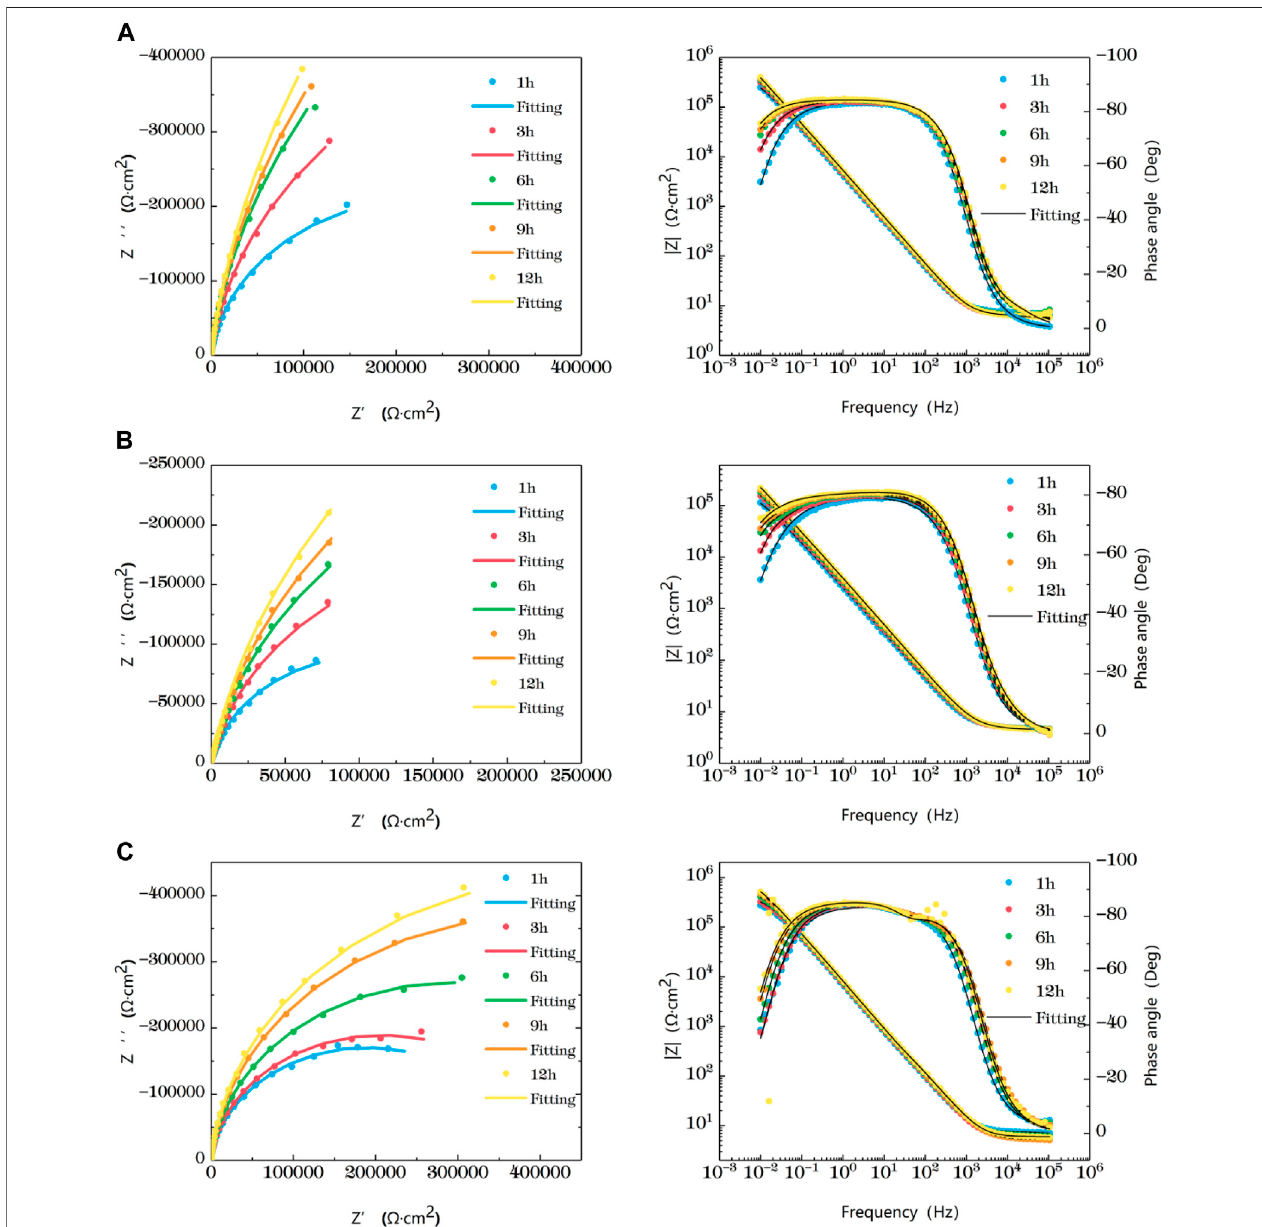
FIGURE 2 | Impedance change of base metal area soaked in arti fi cial seawater at different temperatures for 12 h (A) 25 ° C (B) 35 ° C (C) 45 ° C.